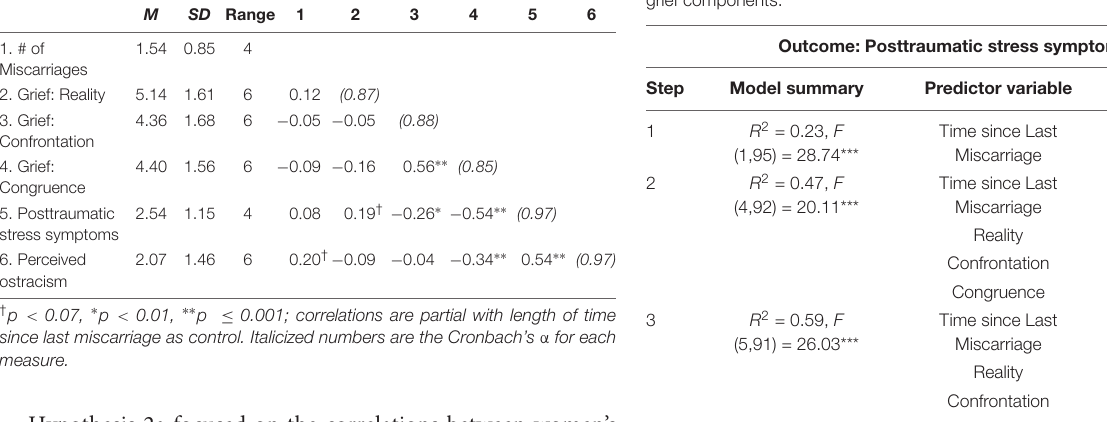
TABLE 1 | Descriptive statistics, inter-correlation matrix, and scale reliabilities. TABLE 2 | Incremental variance explained by perceived ostracism over grief